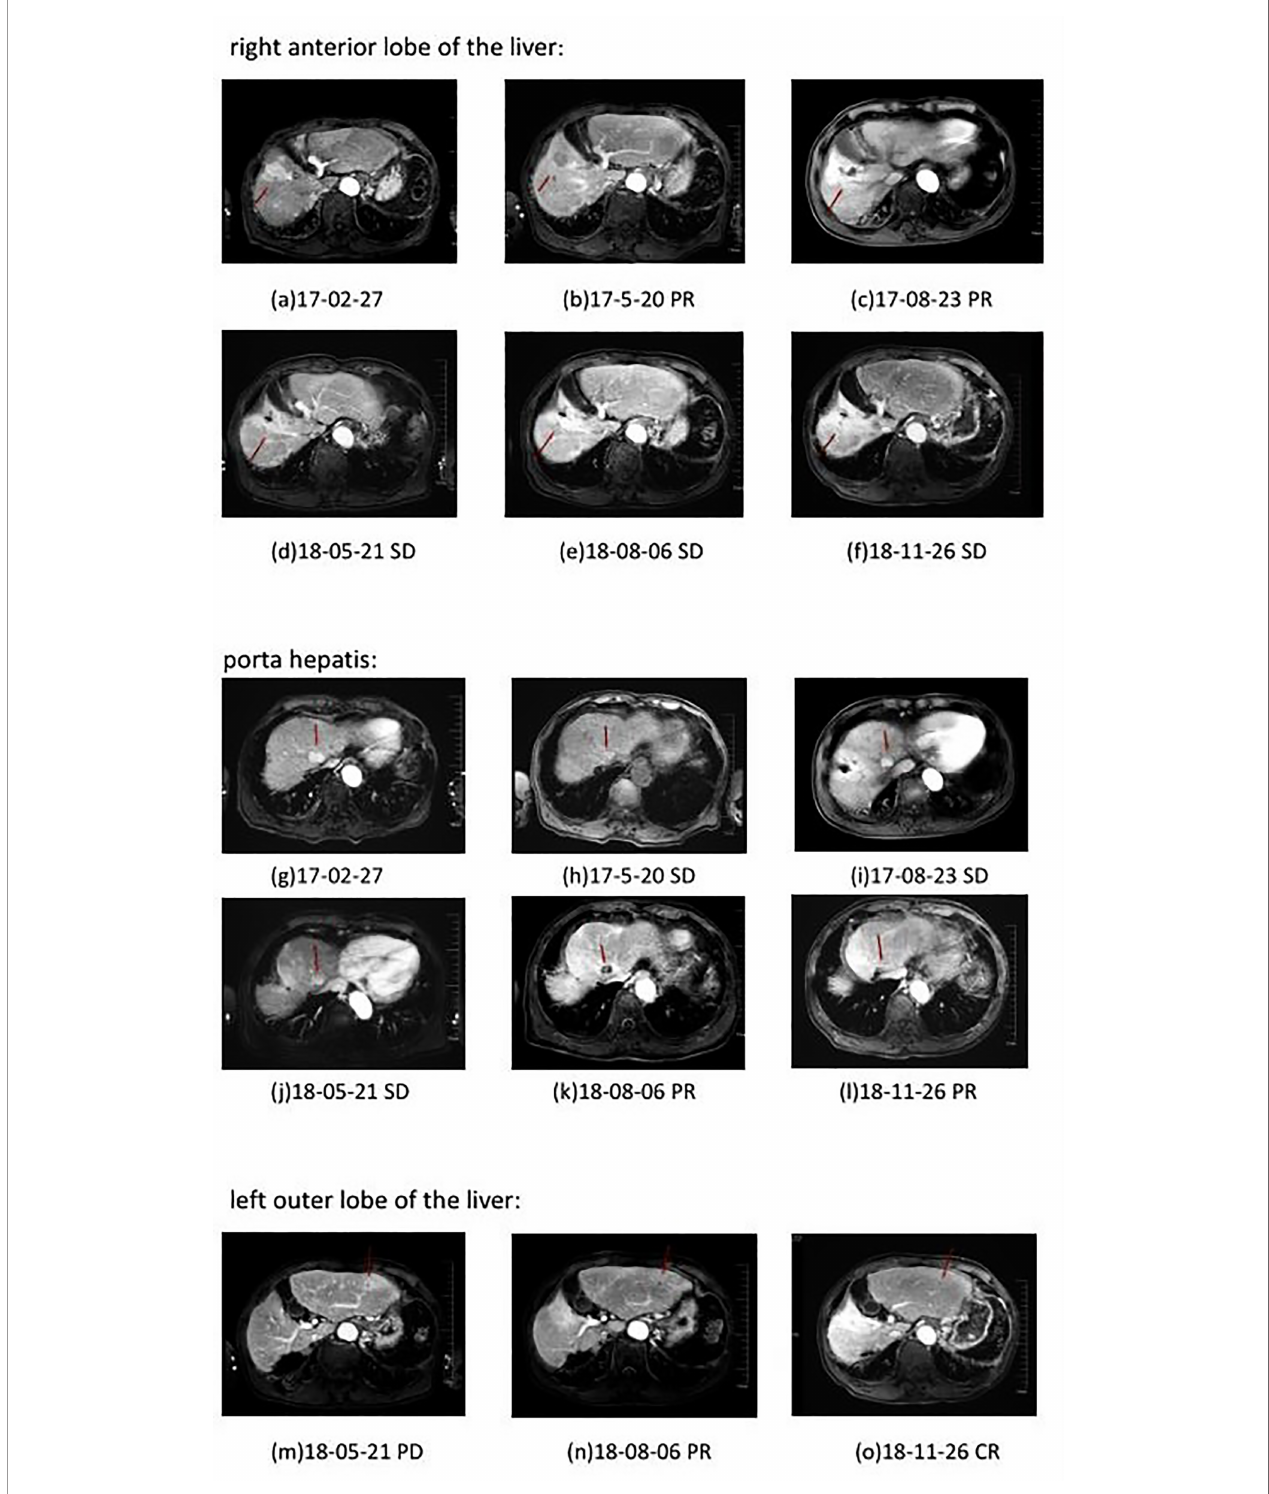
FIGURE 2 | Plain and enhanced MRI of lesions in different parts of patient in different periods. a – f: right anterior lobe of the liver; g – l: porta hepatis; m – o: left outer lobe of the liver. Ef fi cacy evaluation: PD, Disease progression; SD, Stable disease; PR, Partial response; CR, Complete